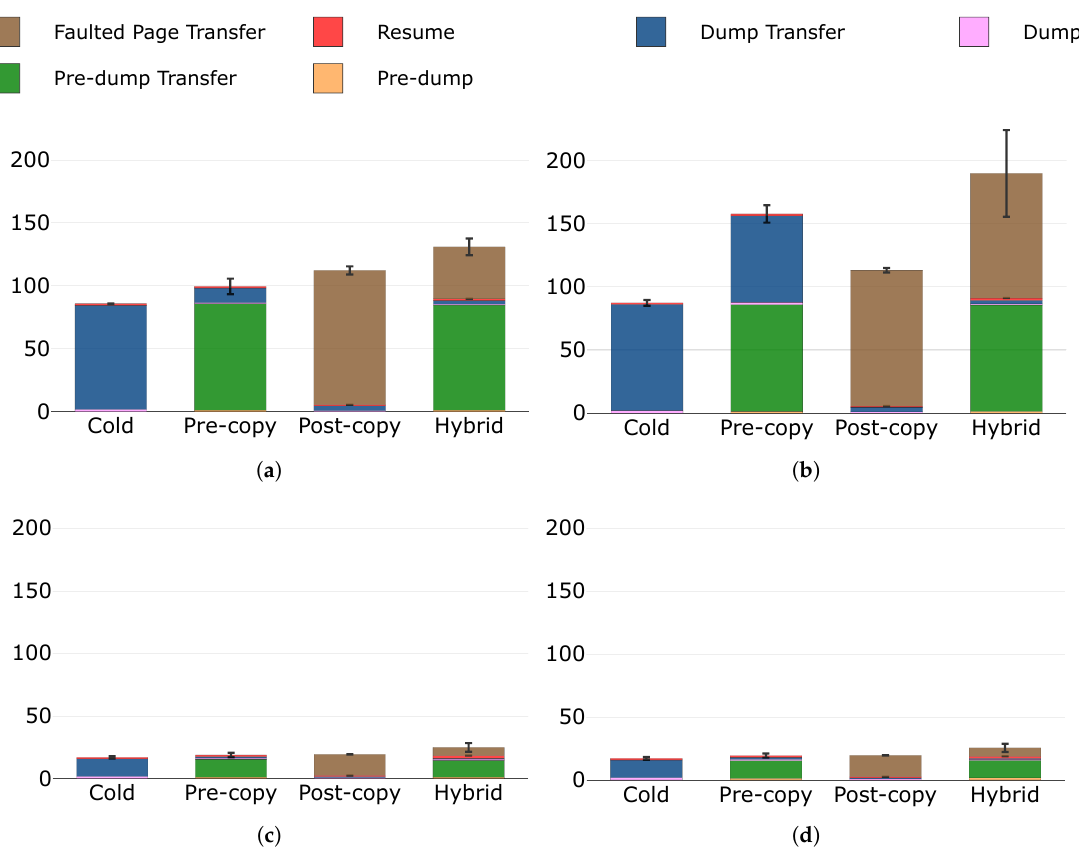
Figure 7. Total migration times (s) with their components in evidence under: ( a ) configuration A; ( b ) configuration B; ( c ) configuration C; and ( d ) configuration